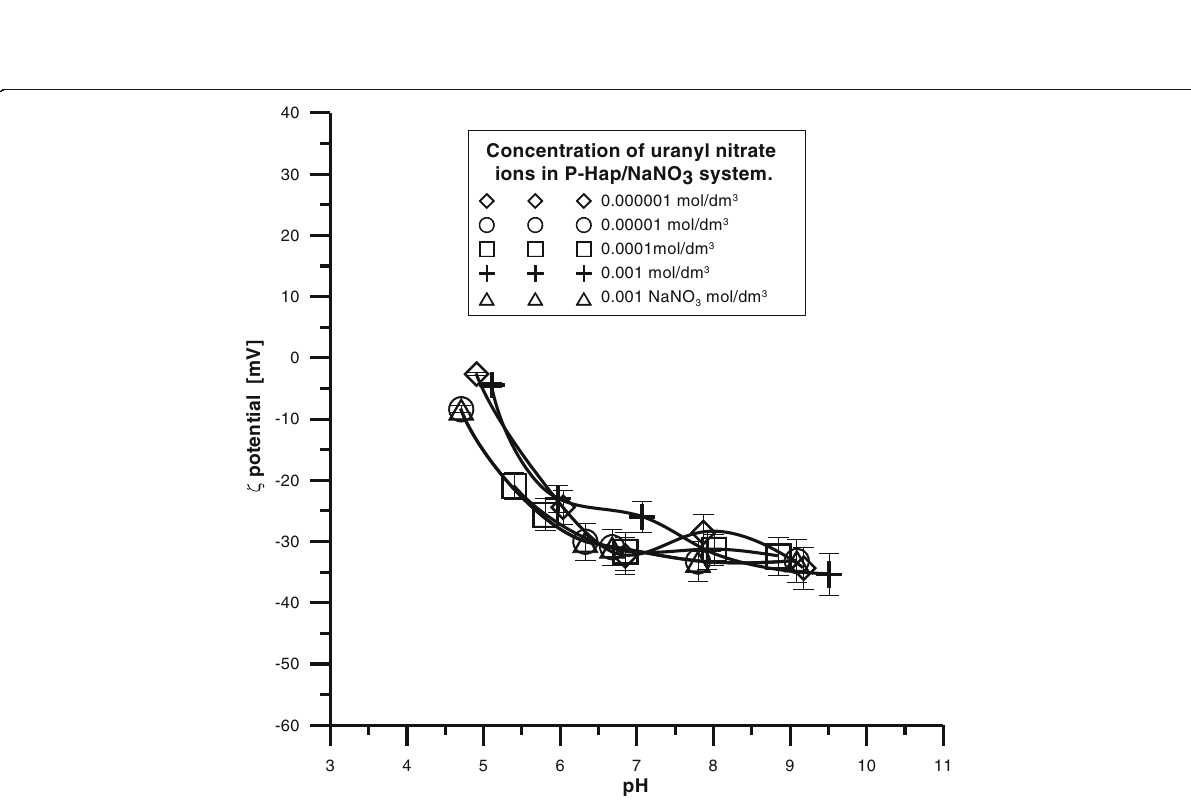
Fig. 10 The zeta potential as a function of pH for P-HAP dispersed in NaNO 3 solution with different concentrations of uranyl nitrate